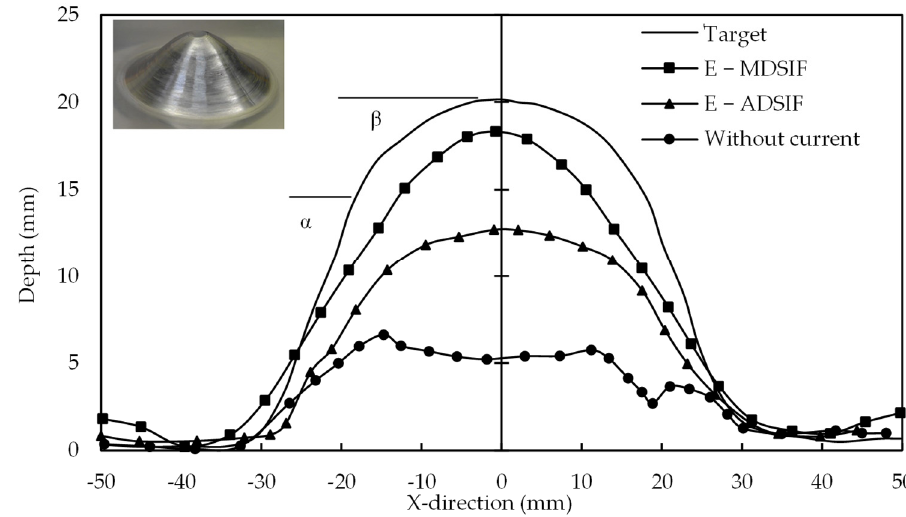
Figure 19. Formed part geometric error comparison (where α = 50°, β = 20°) (reprinted with permis- sion from Valoppi et al. [79], Copyright 2016 Elsevier).